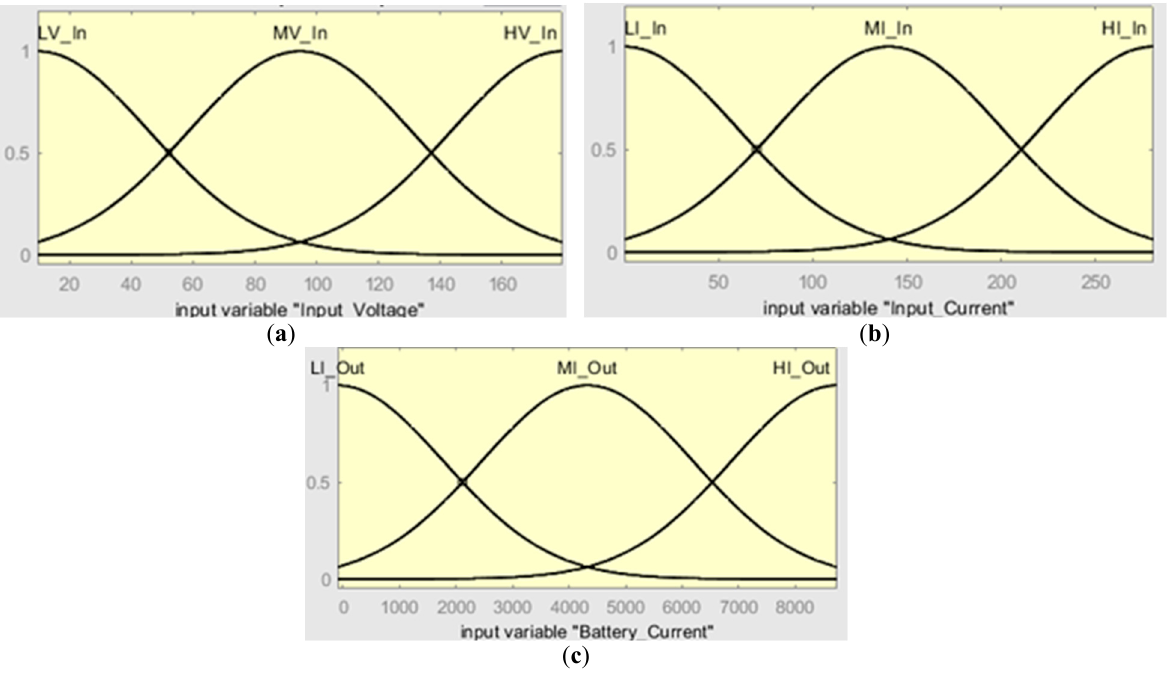
Figure 30. Membership function for the variable ( a ) input voltage, ( b ) input current, and ( c ) battery current.